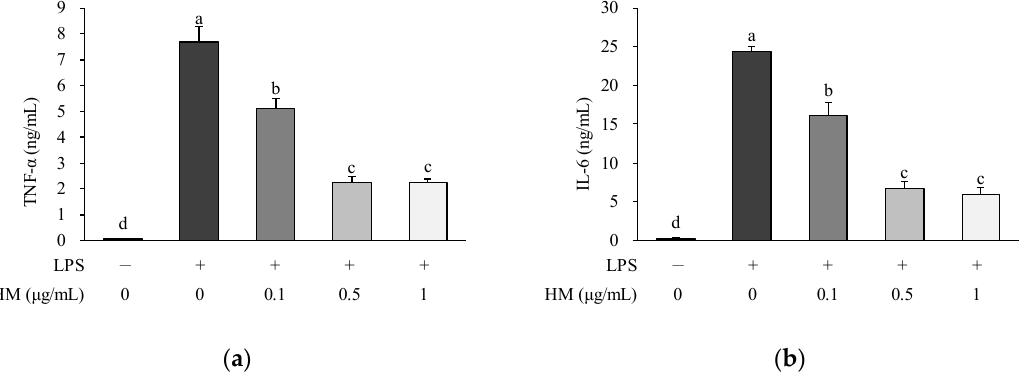
Figure 5. Effects of HM on proinflammatory cytokine production in RAW264.7 cells. Cell were pre-incubated with indicated concentrations of HM for 1 h and then co-incubated with LPS (1 µ g/mL) for 24 h. The amounts of ( a ) TNF − α and ( b ) IL-6 in culture medium were determined using ELISA kits. Values are expressed as mean ± SEM ( n = 4). Different superscript letters indicate statistical significance ( p < 0.05). TNF − α , tumor necrosis factor − α ; IL − 6, interleukin 6; LPS, lipopolysaccharide; HM, high hydrostatic pressure extract of mulberry fruit.